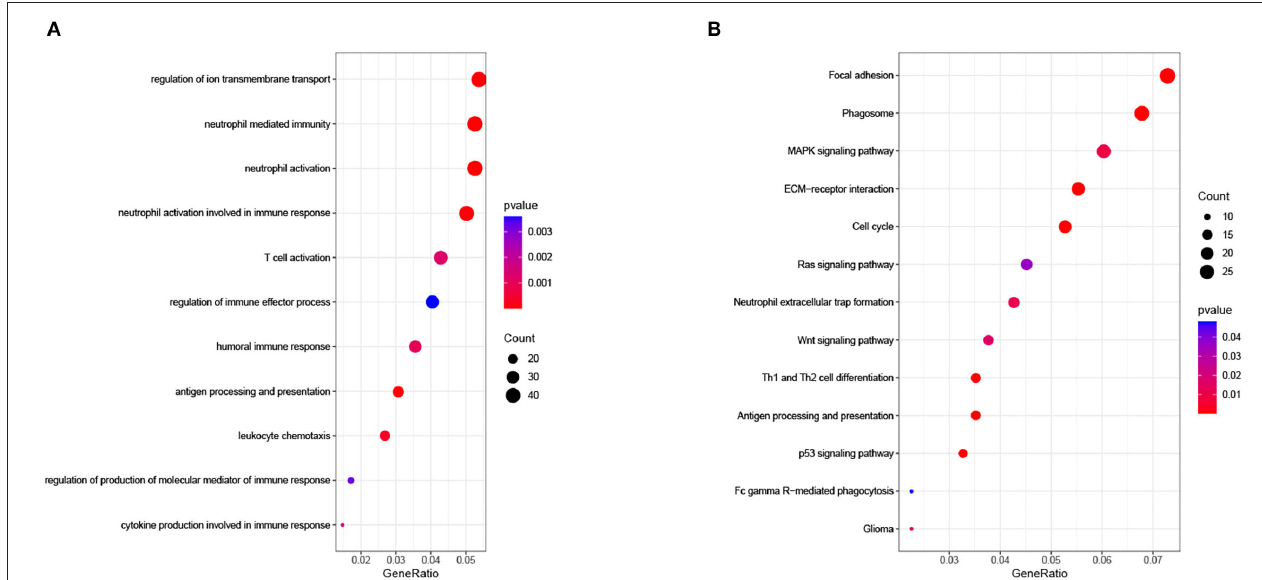
FIGURE 8 | (A) Biological process of Gene Oncology (GO) analysis and (B) Kyoto Encyclopedia of Genes and Genomes (KEGG) pathway analysis in The Cancer Genome Atlas (TCGA) cohort.